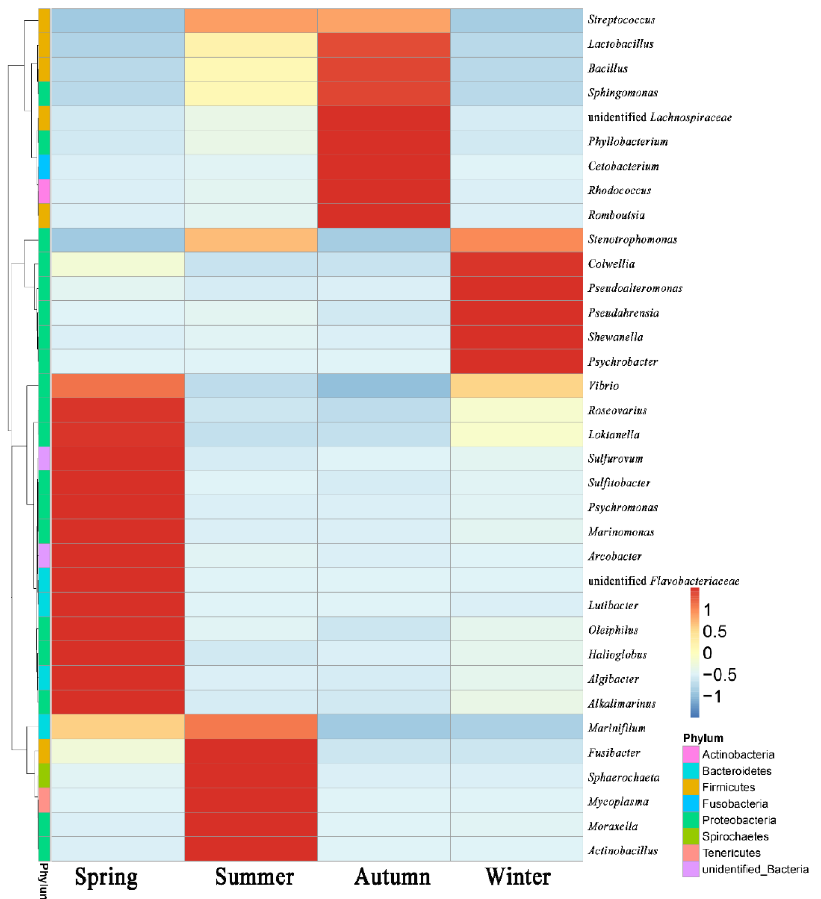
Figure 5. Comparison of the microbial community structures at the genus level on the different seasonal groups.